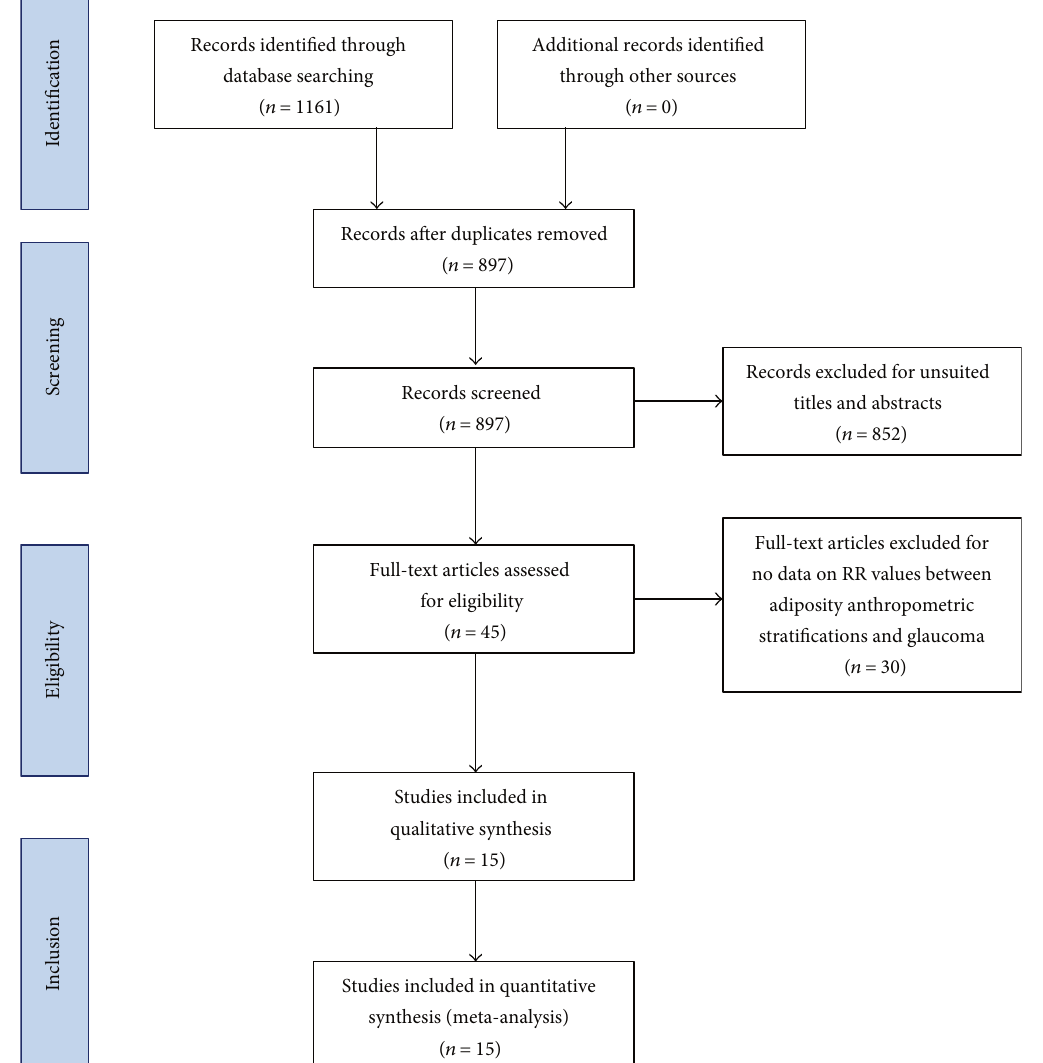
Figure 1: Flow diagram showing the selection process for inclusion of